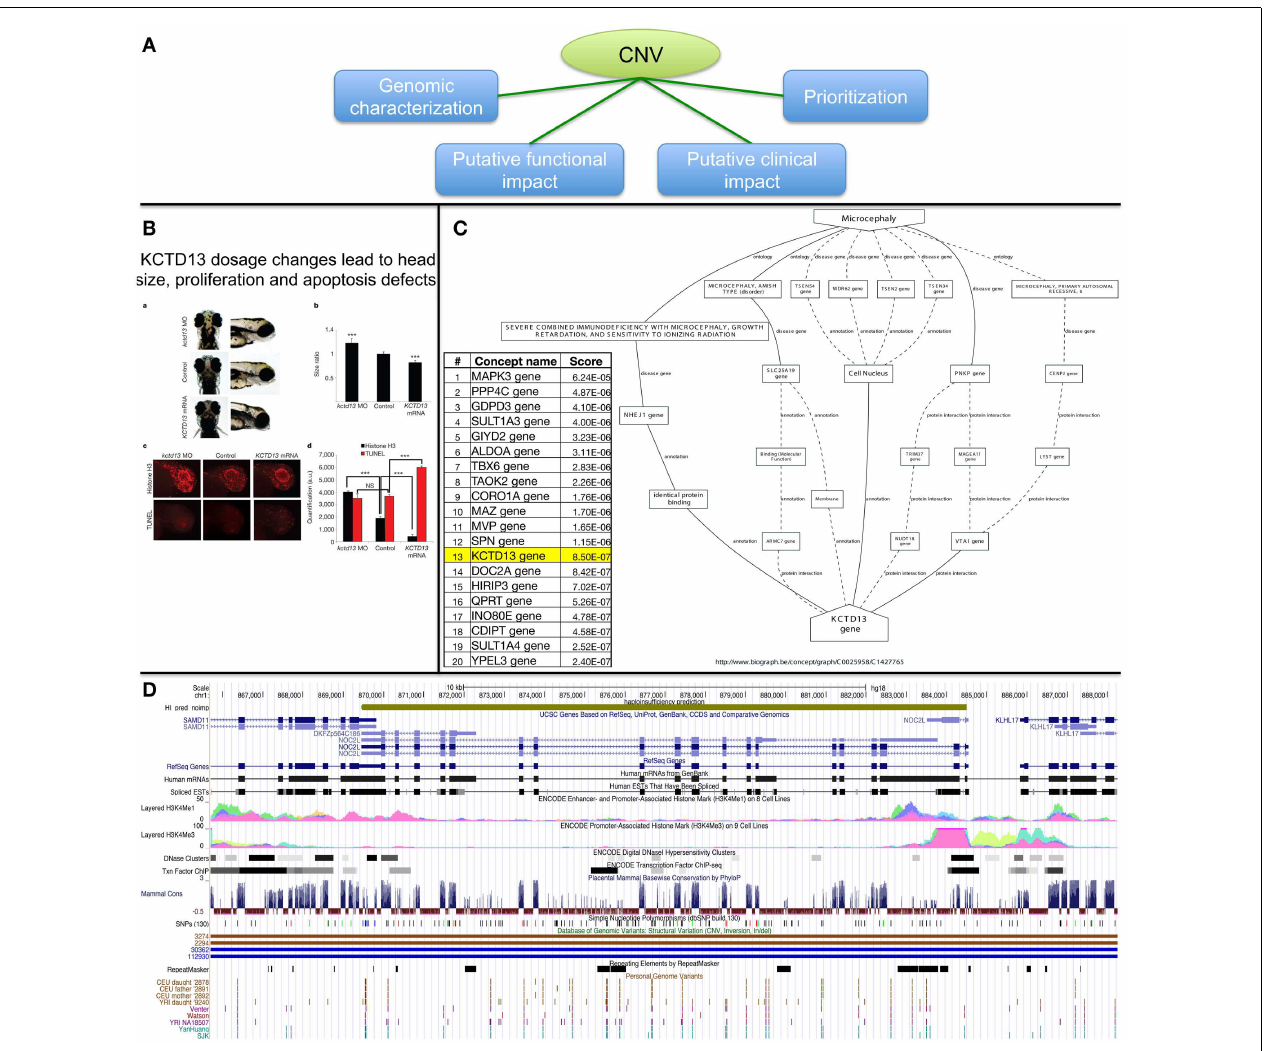
FIGURE 6 | Possible strategies for CNV prioritization . (A) Overview of possible strategies. (B) Functional investigation in animal models (functional impact assessment). (C) Genes ranking based on text-mining approaches (prioritization). (D) Visualization in genome browser (genomic characterization).